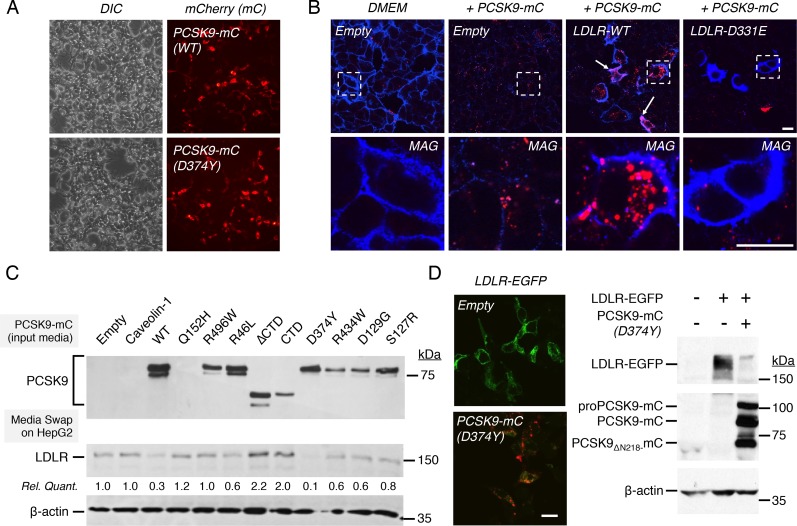
Fusion of monomeric fluorescent proteins to PCSK9 and LDLR.(A) HEK293 cells were transiently transfected with plasmids encoding WT PCSK9-mCherry (mC) or its GOF D374Y mutant and expression was analyzed by fluorescence microscopy with a 20X objective. (B) HEK293 cells were transfected without (Empty) or with WT LDLR or its EGF-A D331E mutant, incubated for 24 h (left panels) or 4 h (right panels) in DMEM or with conditioned media from PCSK9-mC transfected HEK293 cells. LDLR was revealed under non-permeabilizing conditions and protein localization was analyzed by confocal immunofluorescence microscopy. Magnified images of area within dashed lines are shown (bottom panels). Scale bars; 20 μm. (C) Immunoblots (IB) of conditioned media of PCSK9 natural mutants and truncation variants obtained from transiently transfected HEK293 cells (input media). Corresponding media were incubated overnight on HepG2 cells and LDLR and β-actin (loading control) protein levels were analyzed by IB. (D) HEK293 cells were transfected with LDLR-EGFP without (Empty) or with PCSK9 D374Y-mC and both proteins were analyzed by confocal microscopy (left panels) and IB (right panels). Scale bar = 20 μM. Data are representative of at least three independent experiments.